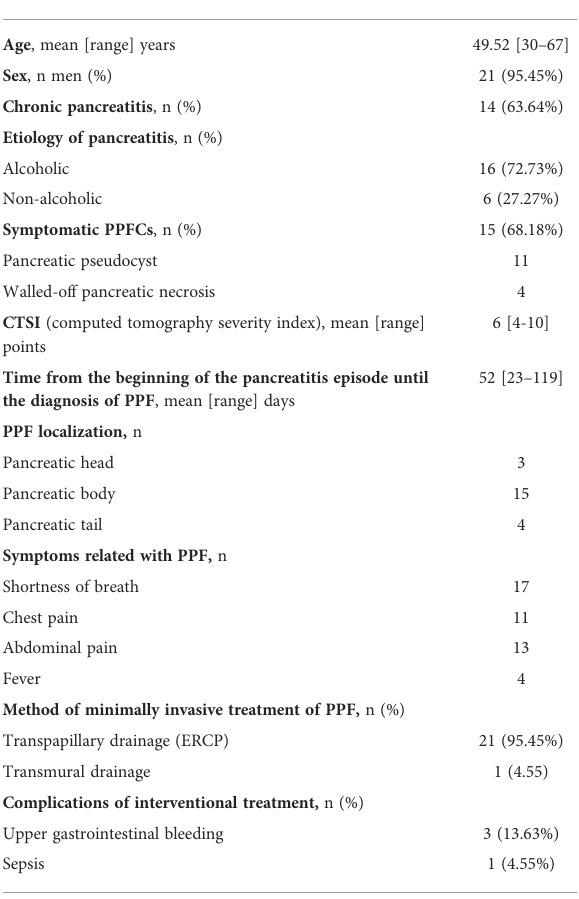
TABLE 1 Characteristics of the patients from study